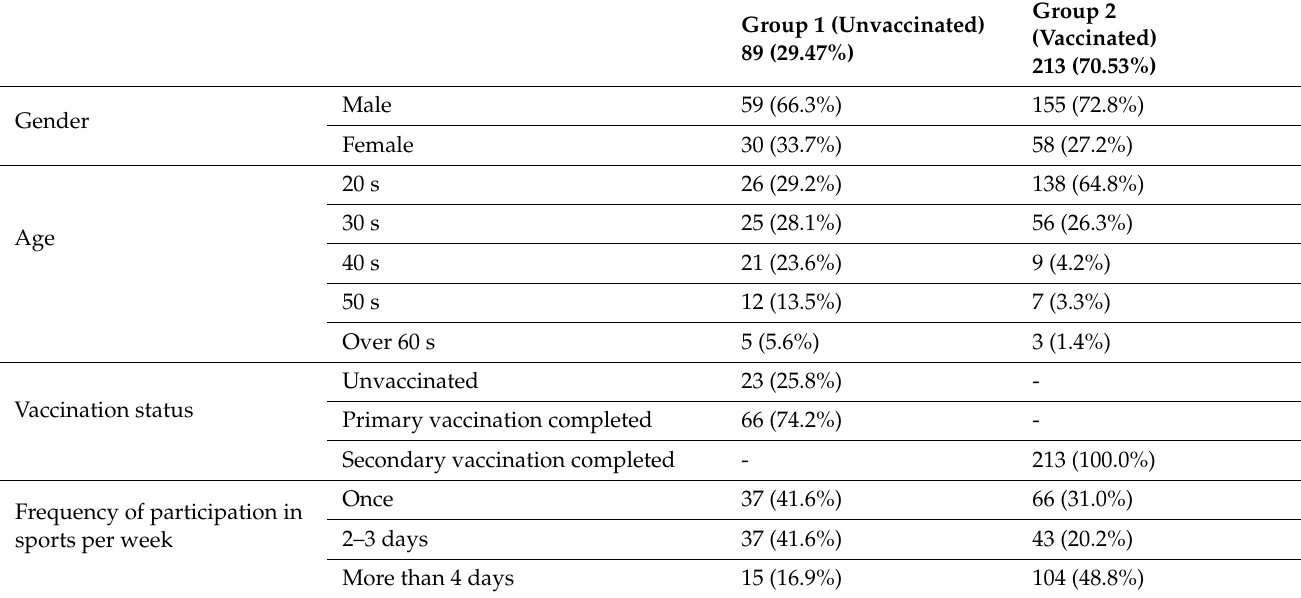
Table 1. Descriptive statistics for survey